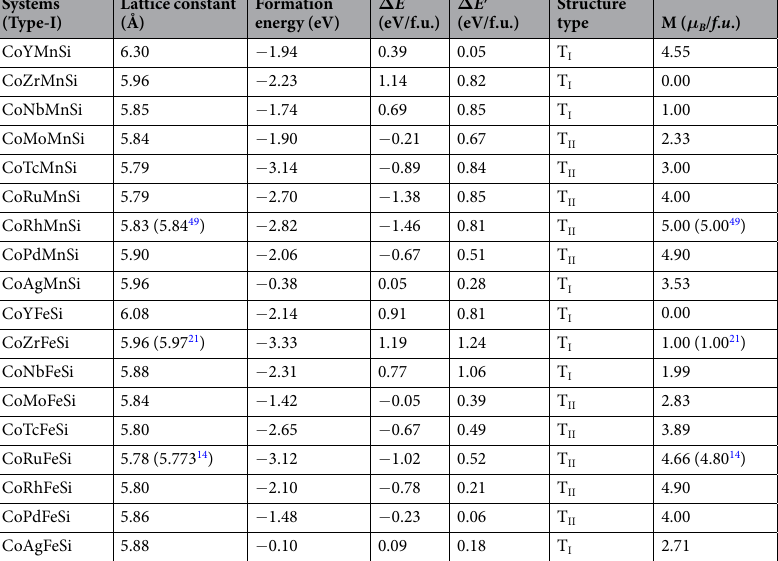
− E . A positive Δ E implies T I as the ground state. The energy T II T I − E ; for the systems which crystallise in Type-I (T I ), T III T II